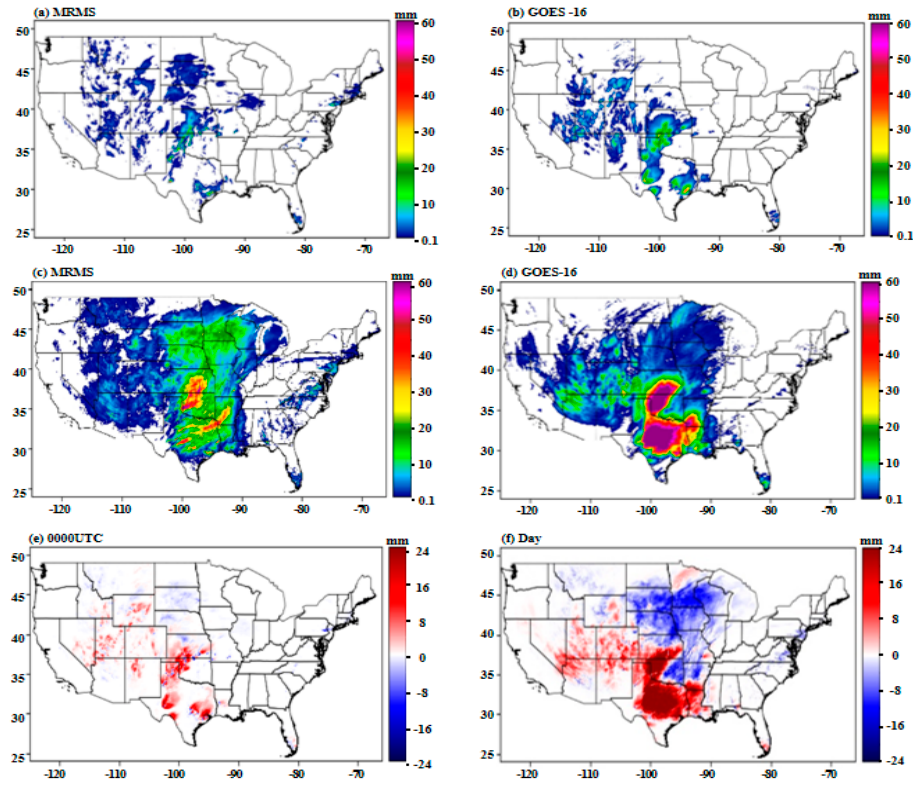
Figure 7. Rainfall accumulations from GC ‐ MRMS and GOES ‐ 16 QPE for the 8 May 2019 event. From left to right: GC ‐ MRMS and GOES ‐ 16 QPE; ( a ) and ( b ) are hourly precipitation accumulations at 0000 UTC; ( c ) and ( d ) are daily rainfall accumulations; and ( e ) and ( f ) are the differences between the GOES ‐ 16 QPE and GC ‐ MRMS for hourly and daily rainfall